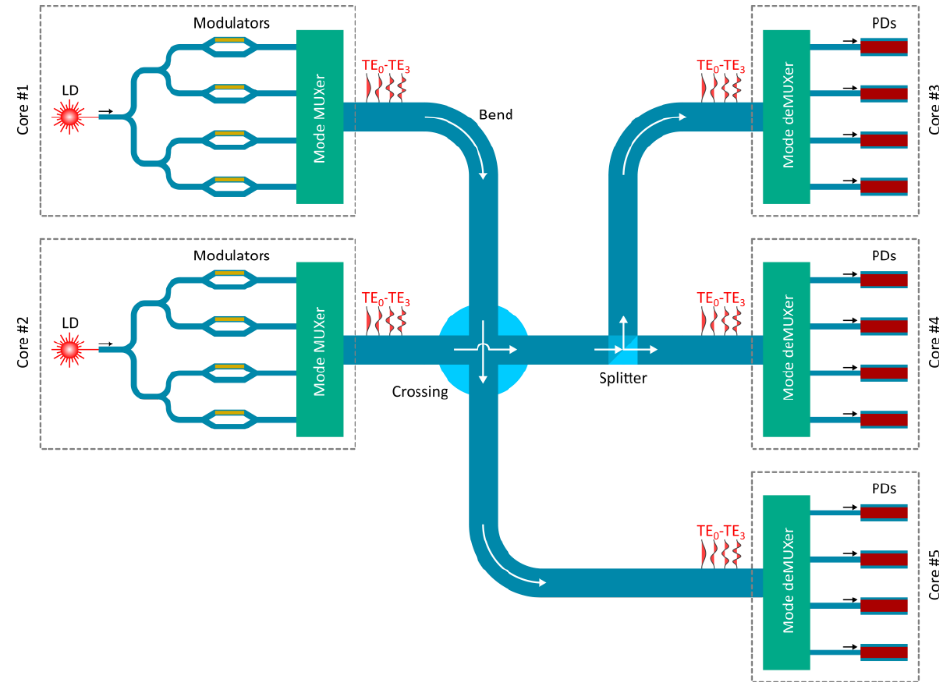
Figure 11. The configuration for MDM-enabled interconnects with multi-mode routing devices.